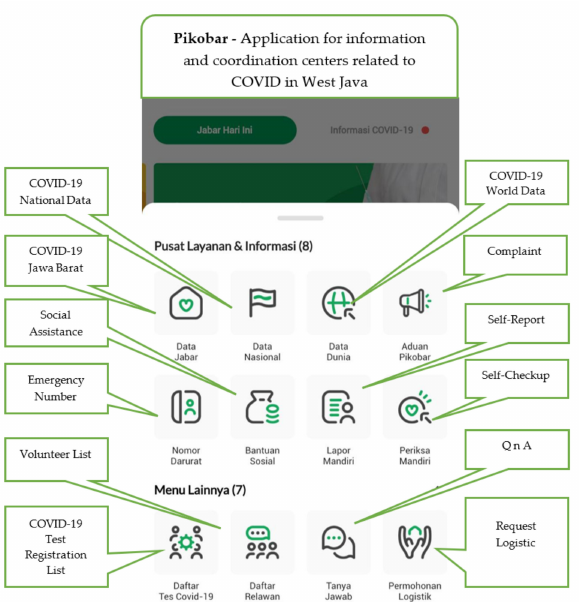
Figure 6. The application “Pikobar” in West Java. Source: [63] accessed on 17 August